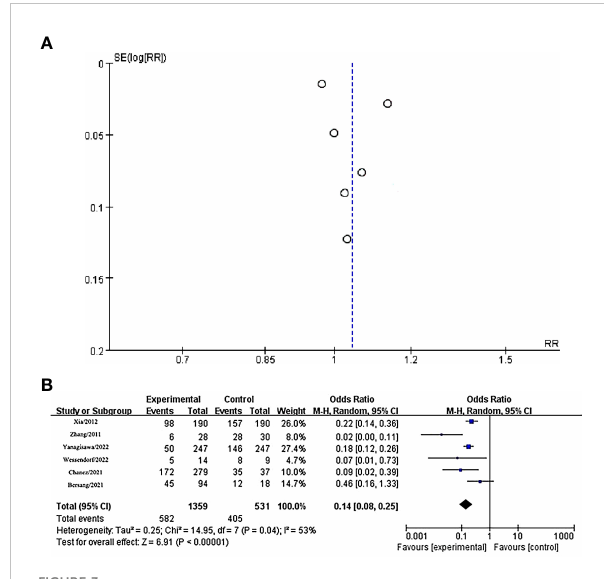
FIGURE 3 (A) A funnel plot of the 5-year survival rate of radiofrequency ablation and partial resection in the treatment of early-stage renal cancer. (B) Forest plot of the 5-year survival rate of radiofrequency ablation and partial resection in the treatment of early-stage renal cancer.